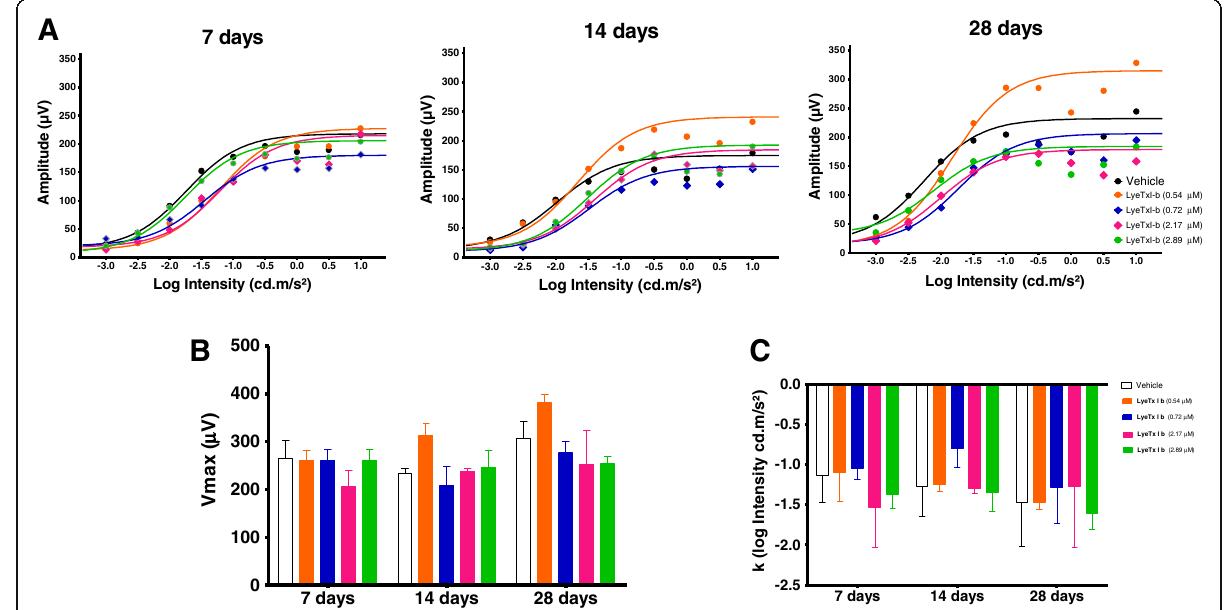
Fig. 7 Log b-wave amplitude versus flash-intensity curves of eyes injected with different doses of LyeTx I b ( a ). Mean difference of the b-wave saturating amplitude (V max ) ( b ). Mean difference of the log semi-saturation constant (k) of the b-wave ( c